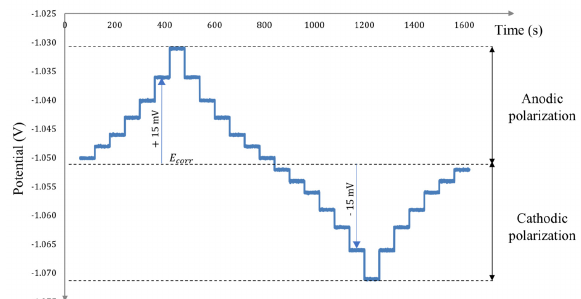
Figure 5 . Potentiostatic polarization steps applied to the working electrode (ZLA).